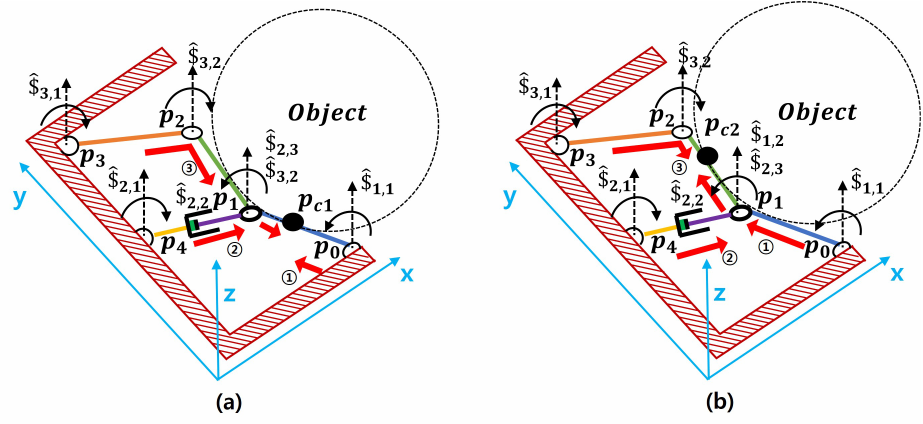
Figure 9. Schematic of force interaction based on screw theory. ( a ) Reciprocal screw in p c 1 . ( b ) Reciprocal screw in p c 2